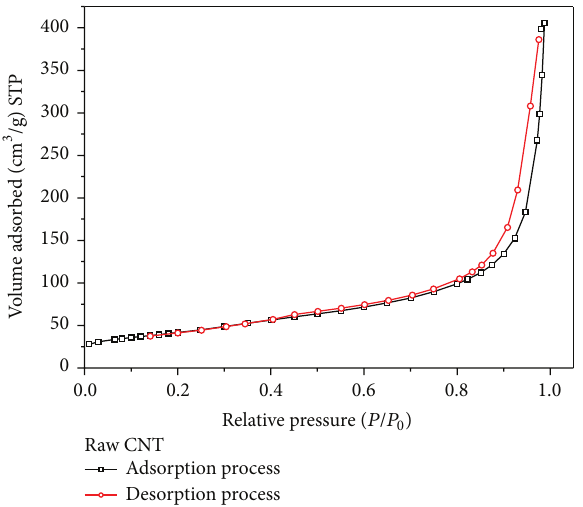
Figure 14: Pore size distribution in raw nanotubes and oxidized